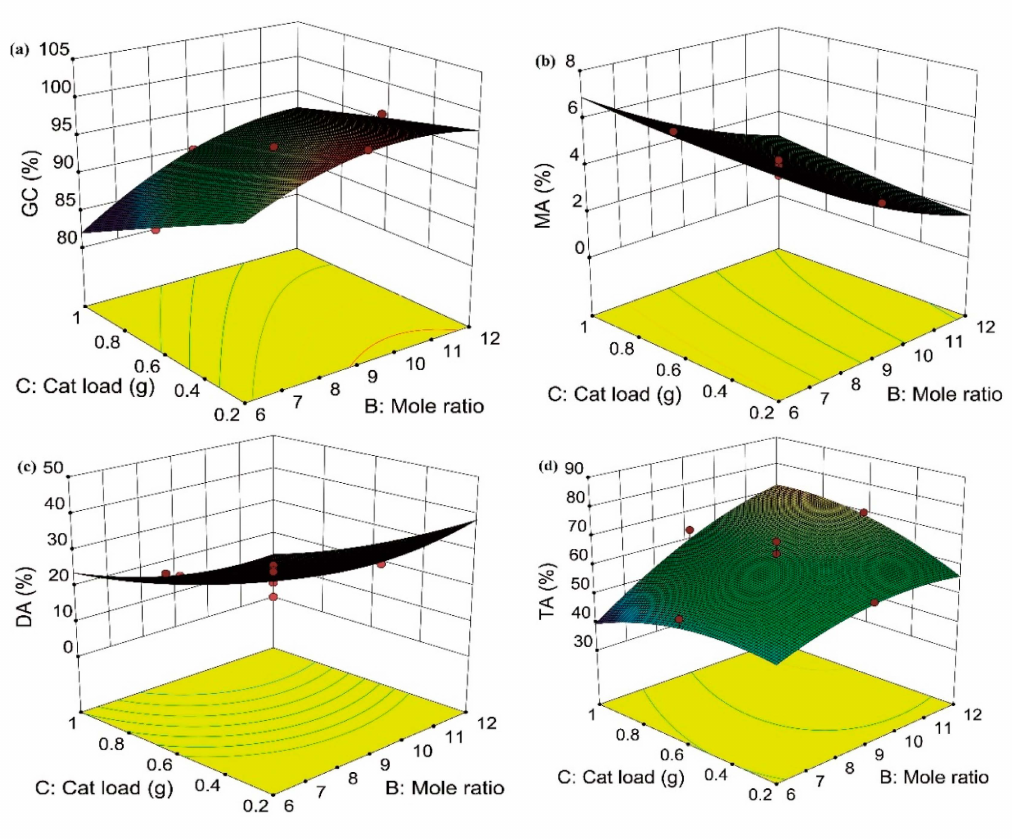
Figure 13. Surface response plots for ( a ) GC and selectivity to ( b ) MA, ( c ) DA, ( d ) TA as a function of the catalyst load, and G / AA mole ratio at a constant temperature (110 ◦ C) and reaction time (3